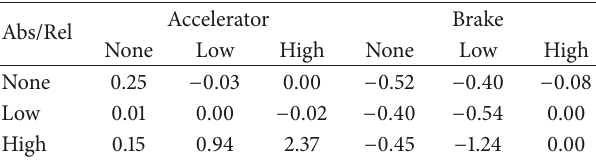
Table 5: ANFIS output